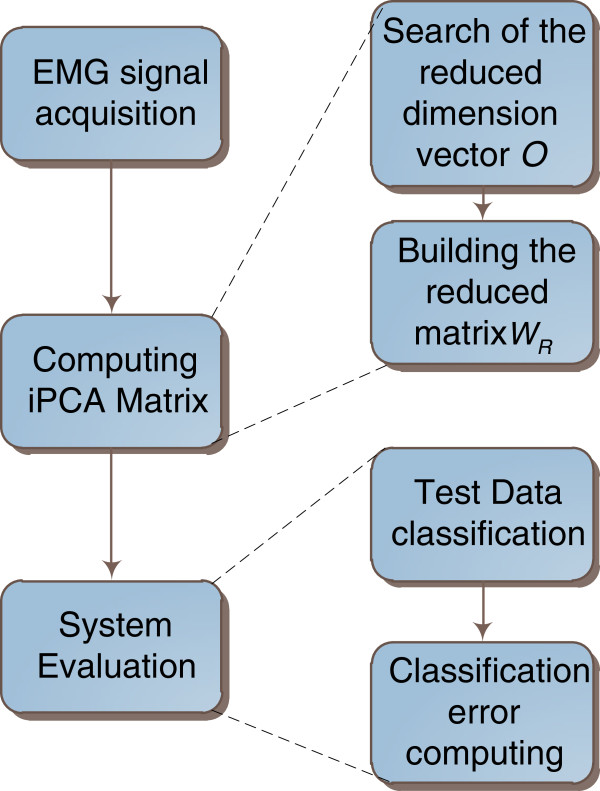
Sequence used to evaluate the classification error. Note that the blocks Computing iPCA Matrix and System Evaluation must run eight times, i.e. one iteration for each of the four search algorithms with the first fitness function (classification error) and one iteration for each of the four search algorithms with the second fitness function (correlation factor).